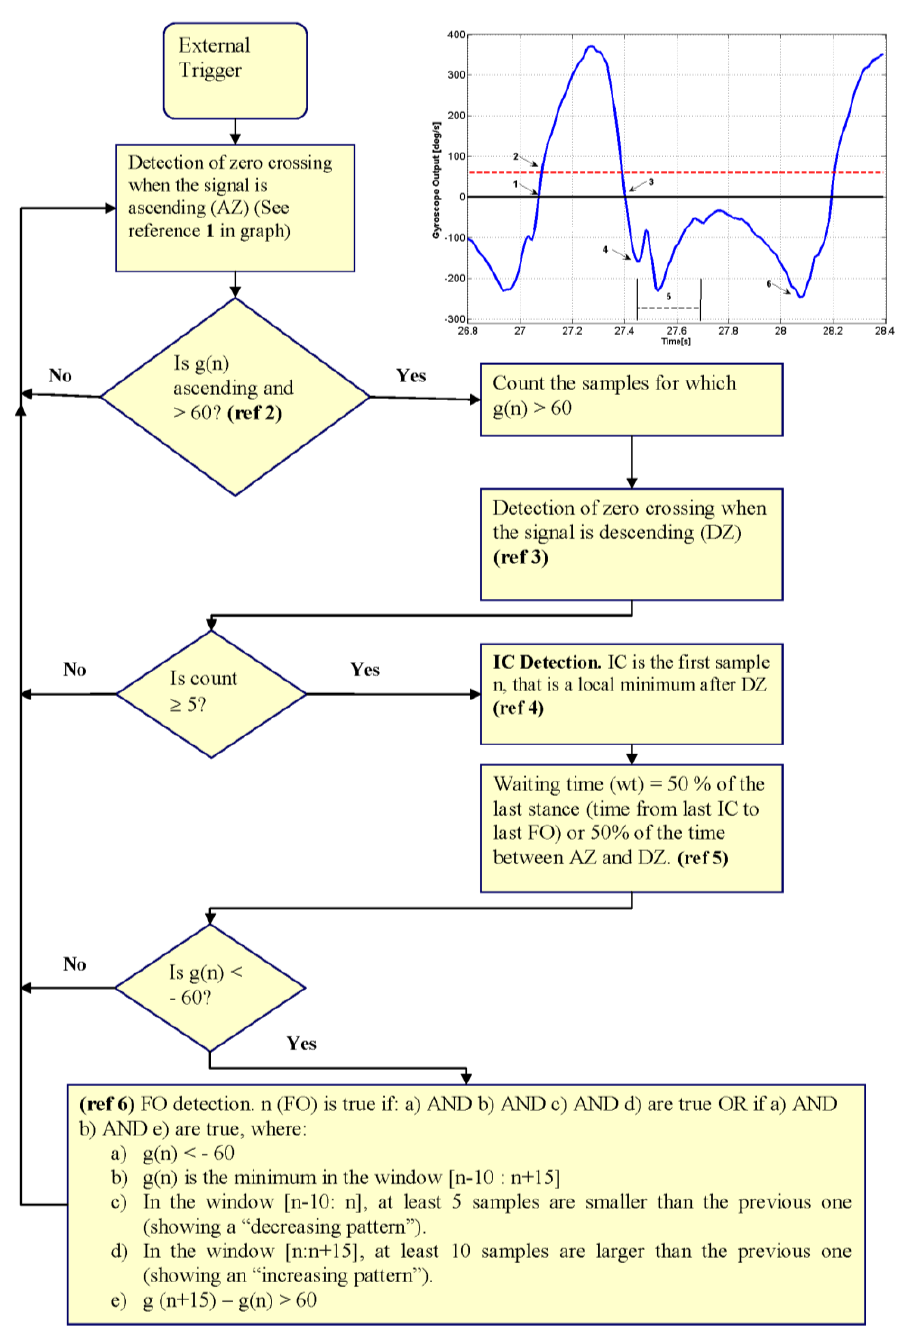
Figure 1. Flowchart of the algorithm used for detection of initial contact (IC) and foot off (FO) from the gyroscope signal (adapted from [27]). The graph corresponds to data collected from one subject who participated in the study. g(n) is the value of the gyroscope signal at the sample n; AZ: ascending zero crossing; DZ: descending zero crossing; and wt: waiting time. The numbers in the graph relate to steps of the algorithm: (1) detection of ascending zero crossing; (2) detection of signal exceeding threshold of 60 deg/s (equivalent to a system output of 0.2 V for this configuration); (3) detection of descending zero crossing; (4) IC detection; (5) waiting time; and (6) FO detection. After FO detection, the algorithm starts